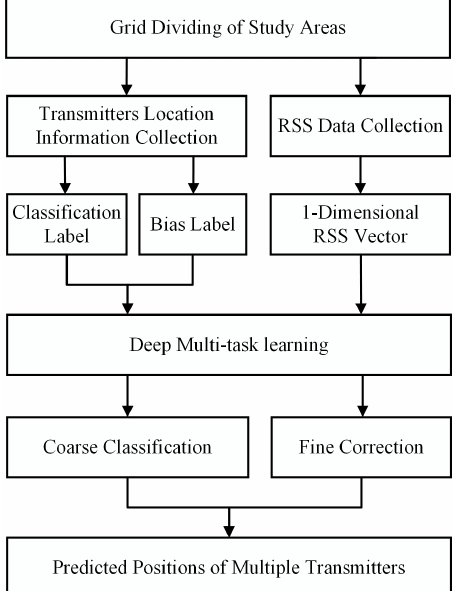
Figure 1. The localization scheme based on the deep multi-task